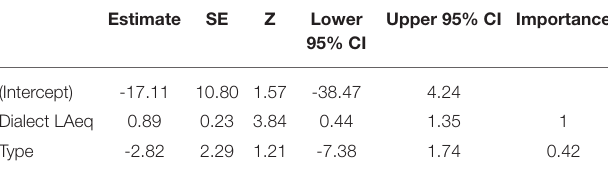
TABLE 3B | Conditional model average of the top three models within